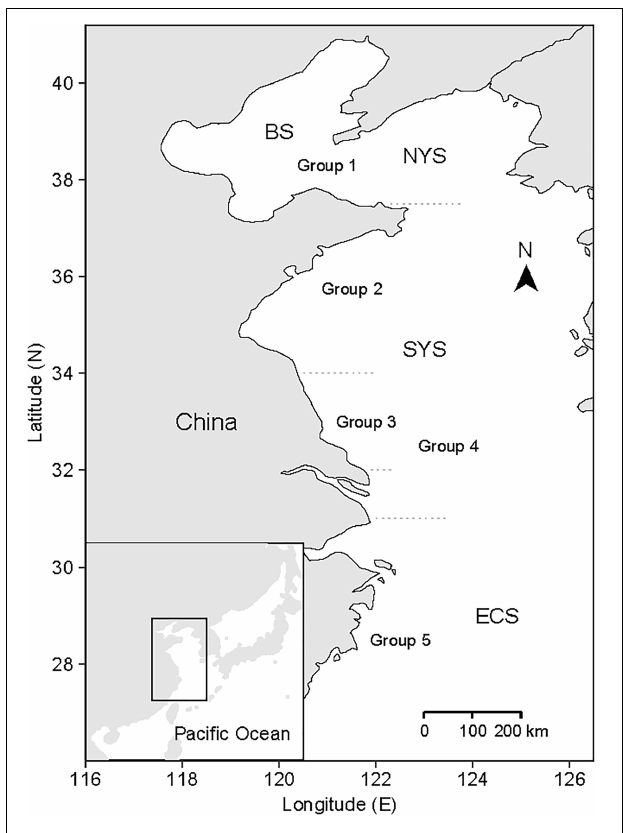
FIGURE 1 | Map of the Bohai Sea (BS), Yellow Sea, and a part of East China Sea (ECS), and the division of groups for small yellow croakers. Yellow Sea consists of North Yellow Sea (NYS) and South Yellow Sea (SYS). The figure was adapted from Zhu et al.